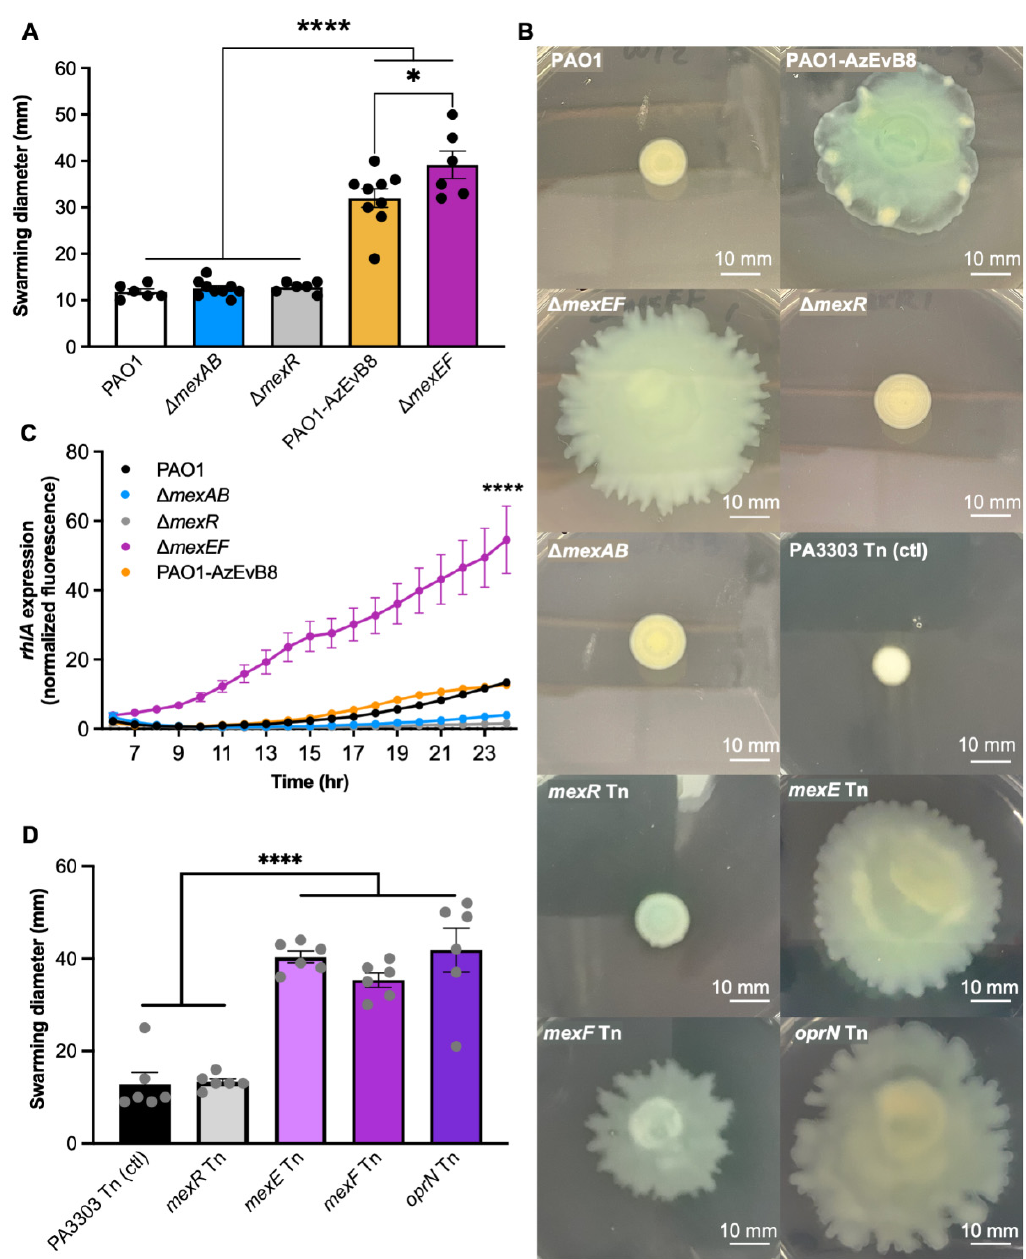
Figure 2. MexEF-OprN mutation increases swarming motility and biosurfactant production. ( A ) Swarming is increased in the PAO1-AzEvB8 and Δ mexEF strains. Measurement of the swarming motility in different mexAB-oprM and mexEF-oprN mutants after 24 h, n = 6–7 replicates/group. ( B ) Representative images of swarming motility from panels ( A and D ). Scale bars indicate 10 mm. ( C ) Rhamnolipid gene expression is increased in the Δ mexEF strain. Rhamnolipid production measured by quantification of rhlA gene expression using a rhlA - gfp promoter reporter fusion to measure GFP fluorescence over time. Gene expression was calculated as area under the curve for each strain and compared to all other groups, n = 6–7 replicates/group. ( D ) Swarming is increased in mexE, mexF, and oprN PAO1 transposon mutant strains. Measurement of the swarming motility in different mexR and mexEF-oprN transposon mutants vs. a neutral Tn mutant control (PA3033) after 24 h, n = 5–12 replicates/group. For all panels, * p < 0.05, **** p < 0.0001, one-way ANOVA, followed by a Tukey’s multiple comparisons test.